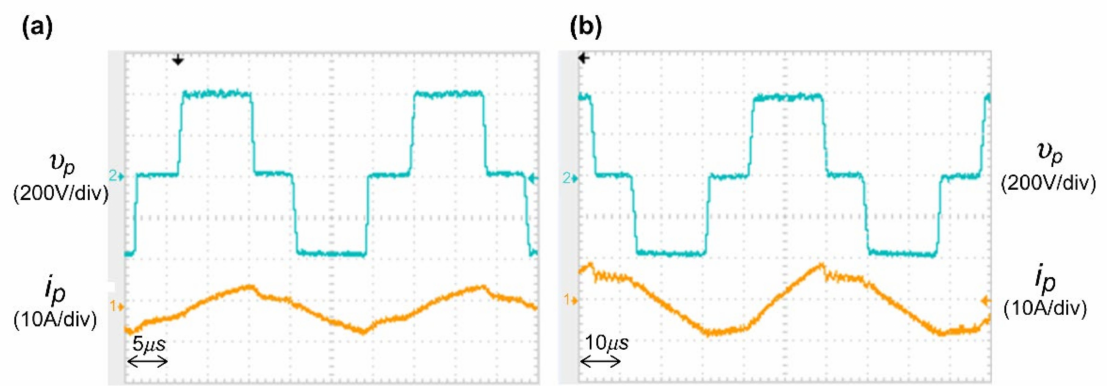
Figure 16. Waveforms of the primary side voltage and currents, v p , i p , of the transformer: ( a ) half-load condition; ( b ) full- Energies 2021 , 14 , 4206 21 of 24 load condition.